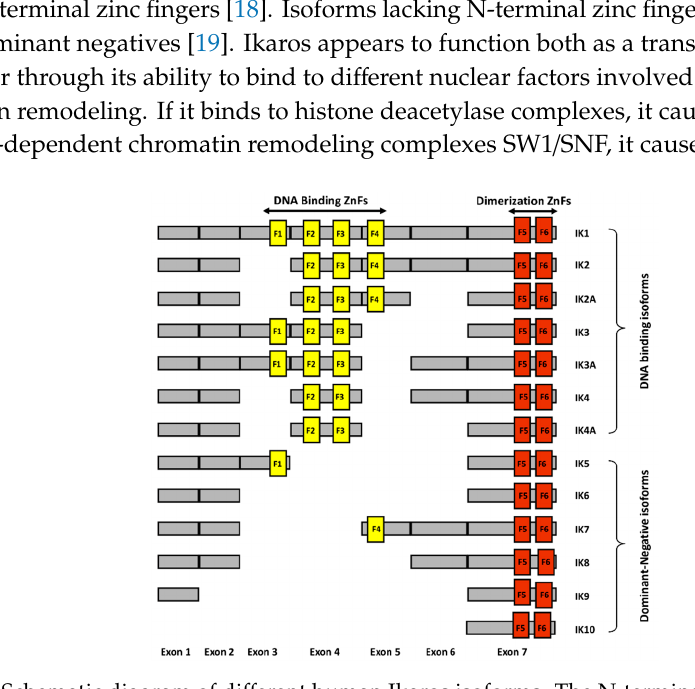
Figure 1. Schematic diagram of different human Ikaros isoforms. The N-terminal zinc fingers (F1 – F4) are shown in yellow vertical bars and C-terminal zinc fingers (F5 – F6) are shown in orange vertical bars.